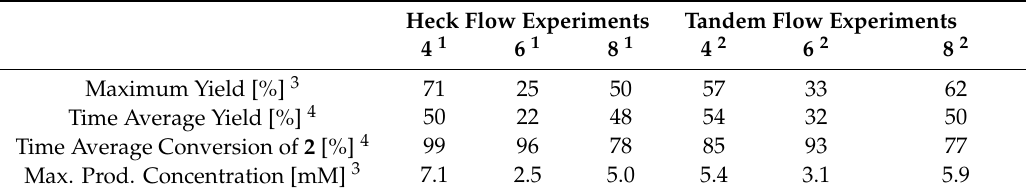
Table 1. Results of the Heck reaction and chemoenzymatic tandem